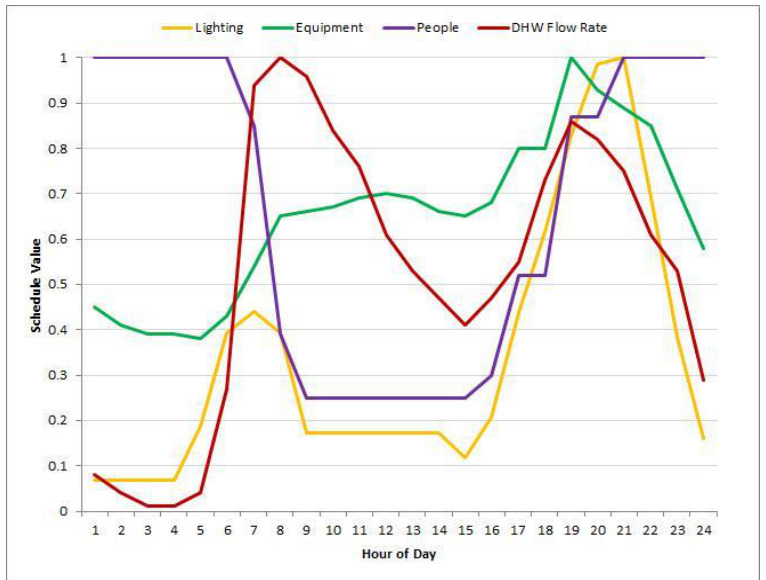
Figure 3. Schedules of occupancies and lighting system, DHW system, and equipment usage in the building.